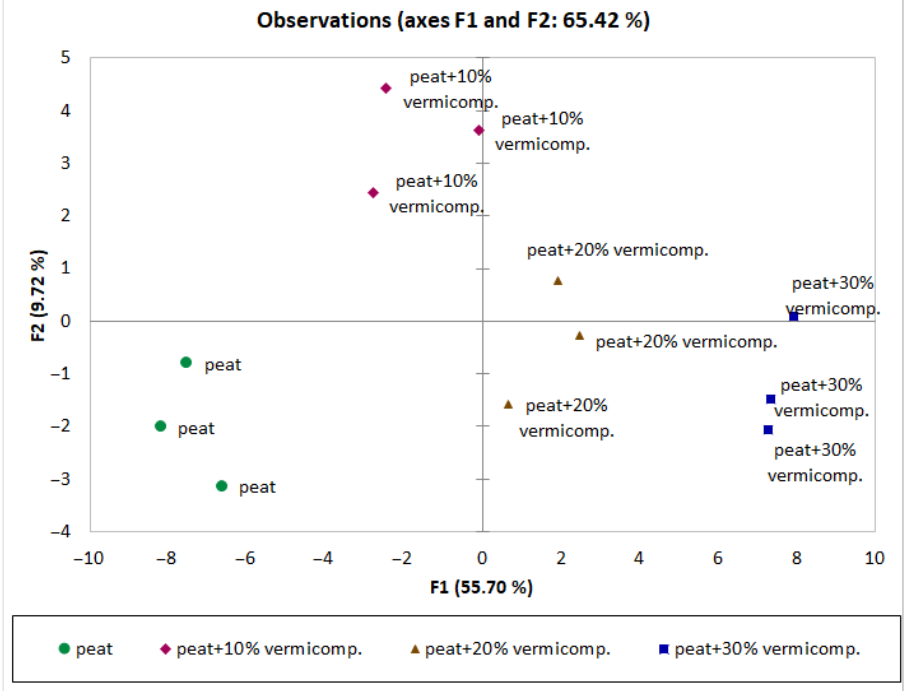
Figure 7. The principal component analysis (PCA) scatterplot, indicating distinct differences in all of the measurements results presented in this paper. the measurements results presented in this